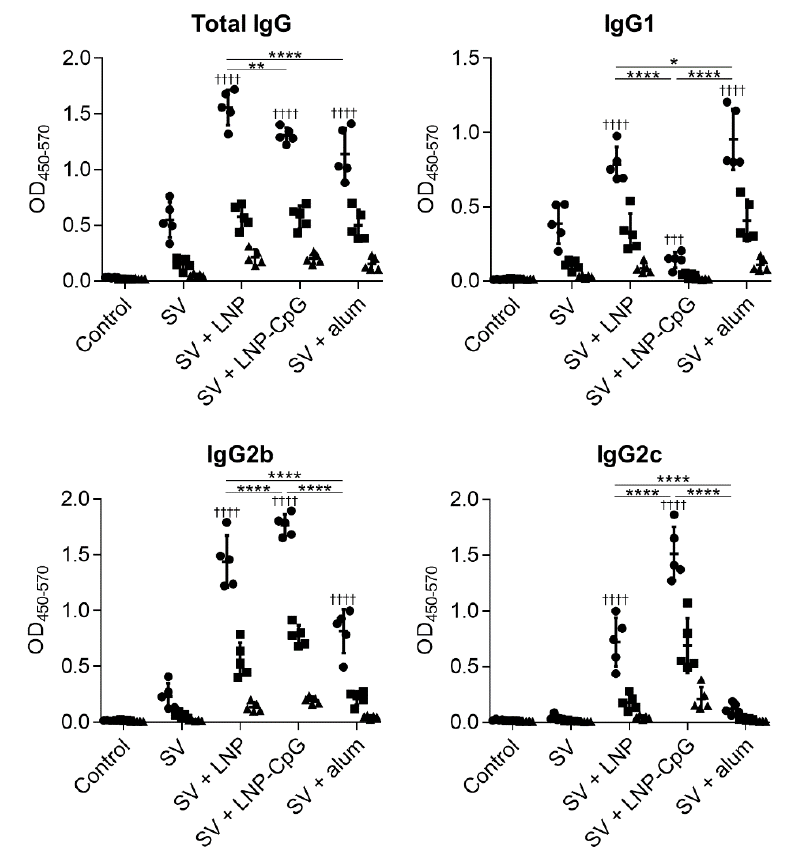
Figure 2. Split vaccine (SV)-specific antibody responses in vivo after first immunization. Mice were subcutaneously immunized with the SV alone, SV plus LNP, SV plus LNP-CpG, or SV plus alum on day 0. On day 14, levels of SV-specific total IgG, IgG1, IgG2b, and IgG2c in plasma were evaluated by using ELISA. We used 800- ( ● ), 4000- ( ■ ), and 20,000- ( ▲ ) fold diluted plasma samples. n = 5 per group. Data are means ± SD. Significant differences were only analyzed in the 800-fold-diluted plasma samples. ††† p < 0.001, and †††† p < 0.0001 vs. group immunized with the SV alone; * p < 0.05, ** p < 0.01, and **** p < 0.0001, as indicated by Tukey’s test.